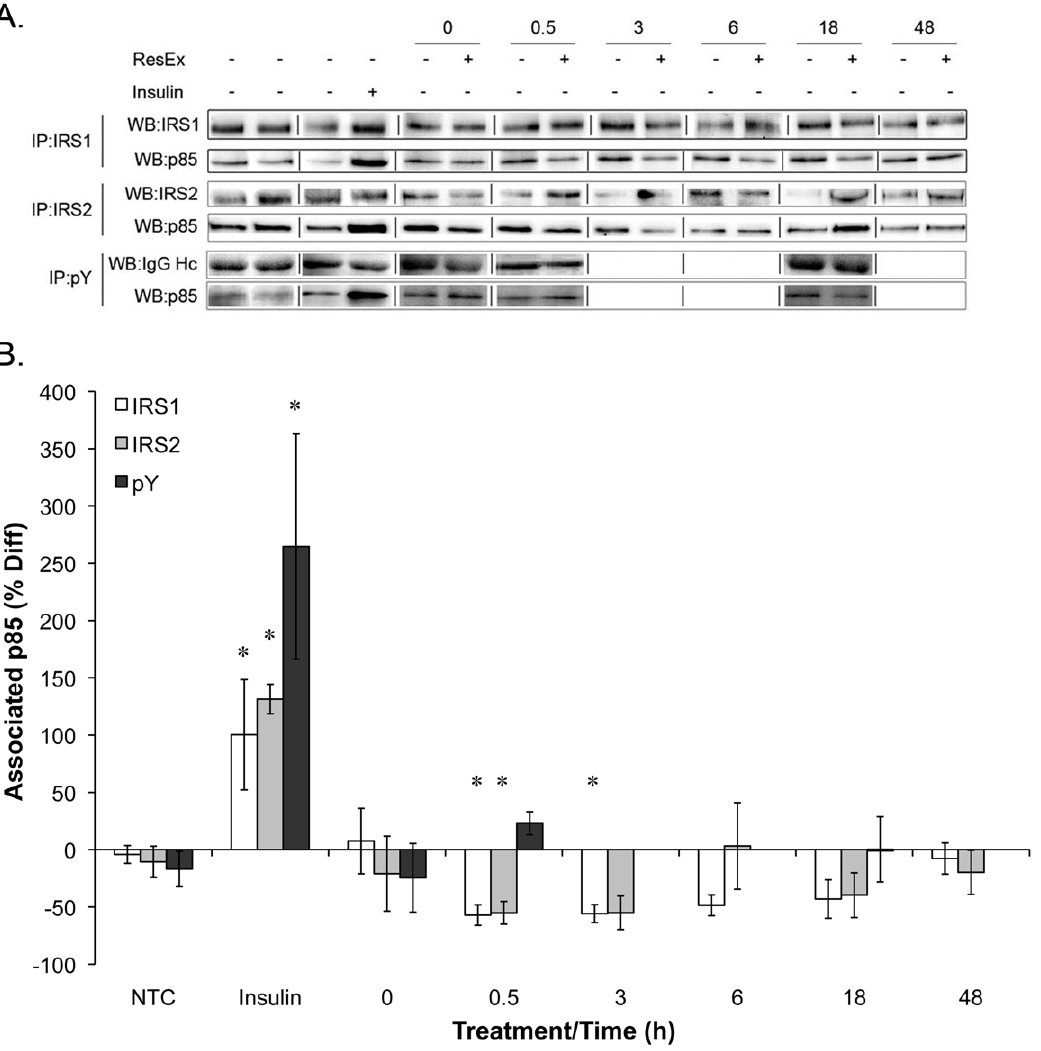
Figure 2. IRS1/2 and pY associated p85 is unchanged following a single bout of resistance exercise. IRS1, IRS2, or phosphotyrosine containing proteins were immunoprecipitated from the right and left TA muscles (n=4) following resistance exercise and the resulting western blot (A) was probed with the antibody to the p85 regulatory subunit of PI3K and the immunoreactivity was quantified in panel (B). * Indicates significantly different from control leg.